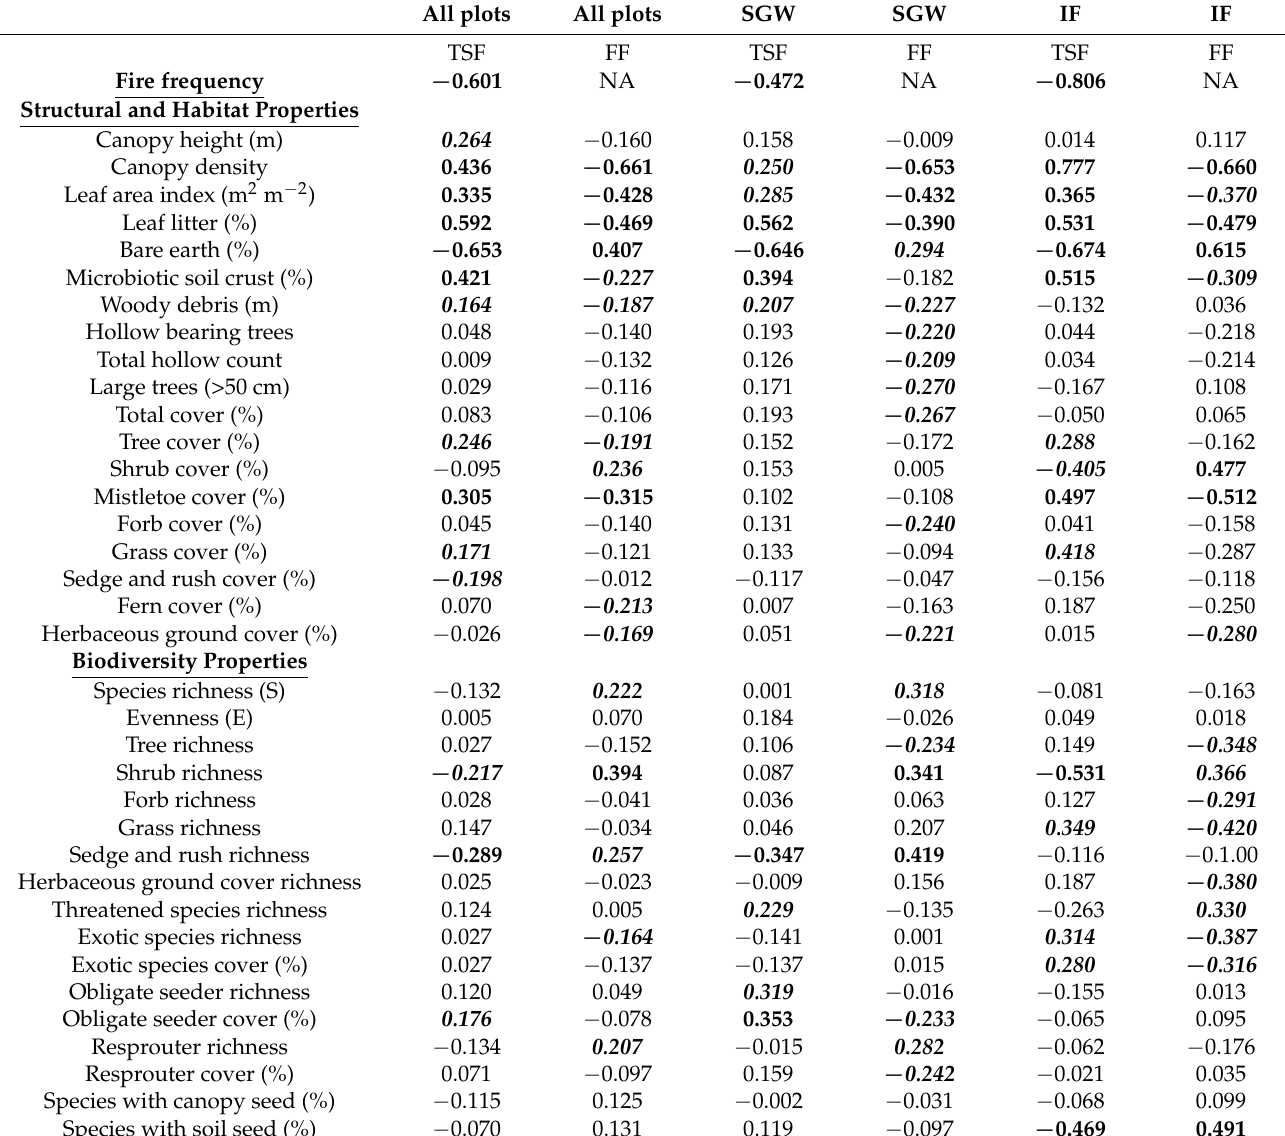
Table 2. Spearman rank order correlation coefficients (r) for relationships between vegetation struc- ture, habitat and biodiversity metrics with time since fire (TSF) and fire frequency (FF), for all plots and individual TECs, Scribbly Gum Woodland (SGW) and Ironbark Forest (IF). Bold/italic indicates p < 0.05; bold indicates p <